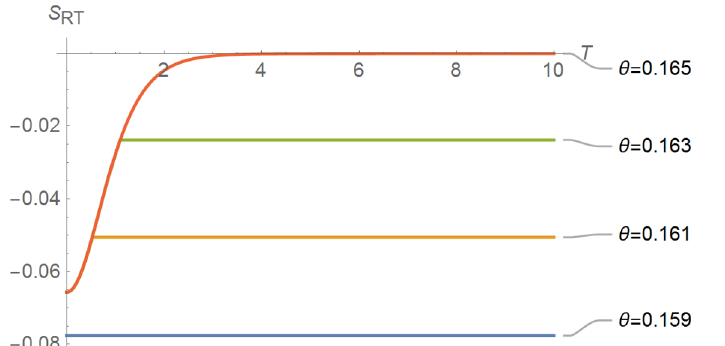
Figure 18 . The entropy (in the unit of l d − 1 L d − 2 θ = 0 . 159 , 0 . 161 , 0 . 163 , 0 . 165 . We also substract the constant term 2 l d − 1